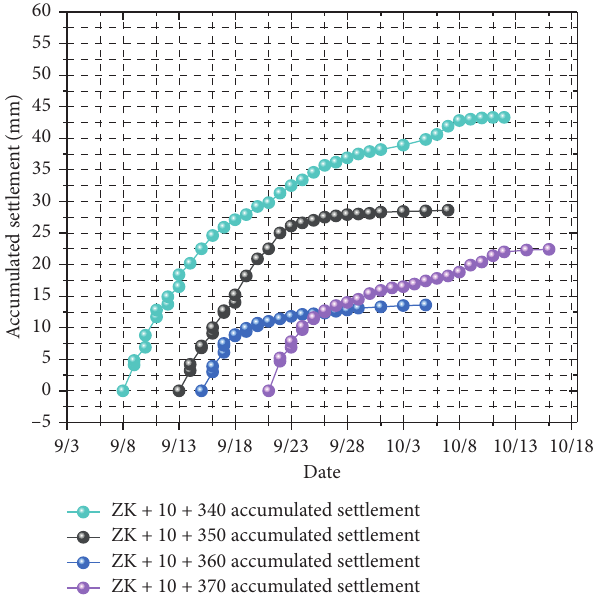
Figure 20: Accumulated settlement of the vault in the four test